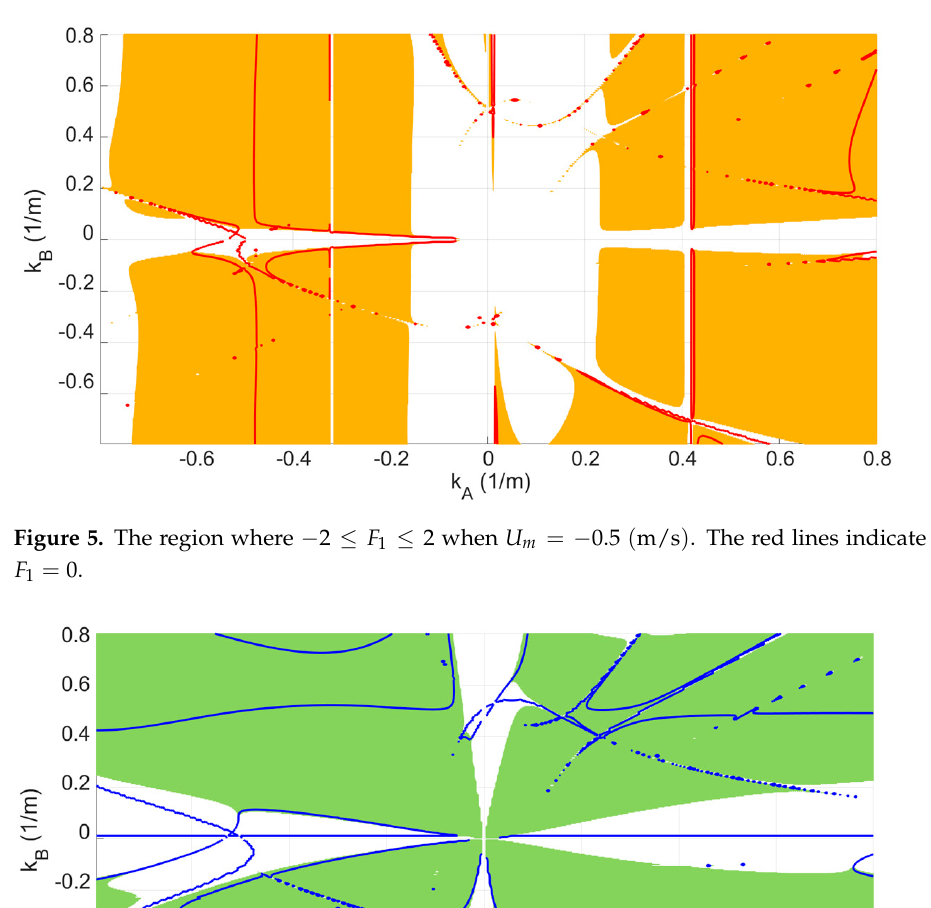
Figure 4. The solutions of 𝐹 (cid:2869) = 0 and 𝐹 (cid:2870) = 0 for 𝑈 (cid:3040) = 0.5 ( m/s ) and 𝛺 (cid:2868) = −0.1(s (cid:2879)(cid:2869) ) . Figure 4. The solutions of F 1 = 0 and F 2 = 0 for U m = 0.5 ( m/s ) and Ω 0 = − 0.1